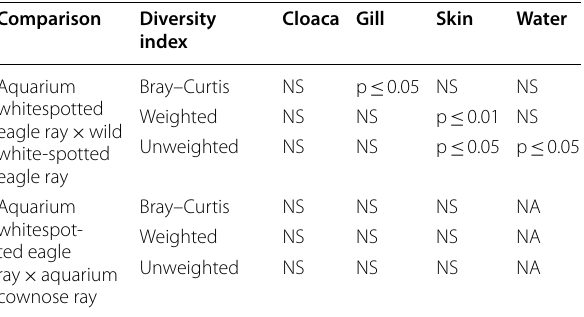
Table 4 Pairwise results for all permutational multivariate analysis of dispersion (PERMDISP) for all β‑diversity metrics and body sites for wild and aquarium whitespotted eagle rays ( Aetobatus narinari ) and aquarium cownose rays ( Rhinoptera bonasus